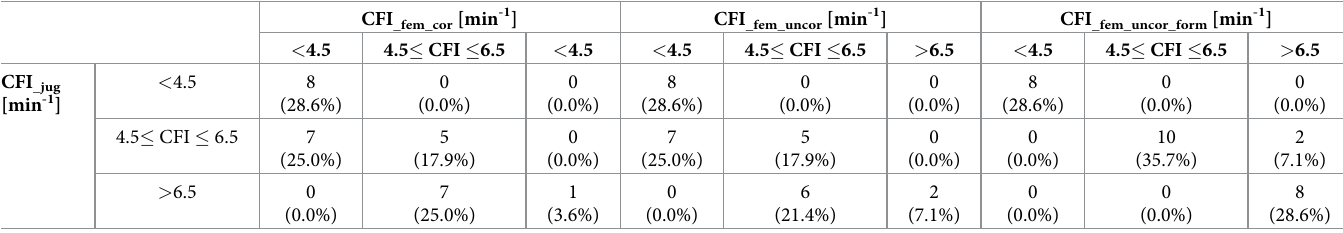
Table 4. Categories of cardiac function index (CFI) classified as decreased (CFI < 4.5 min -1 ), normal (4.5 (cid:20) CFI (cid:20) 6.5 min -1 ) and increased (CFI > 6.5 min -1